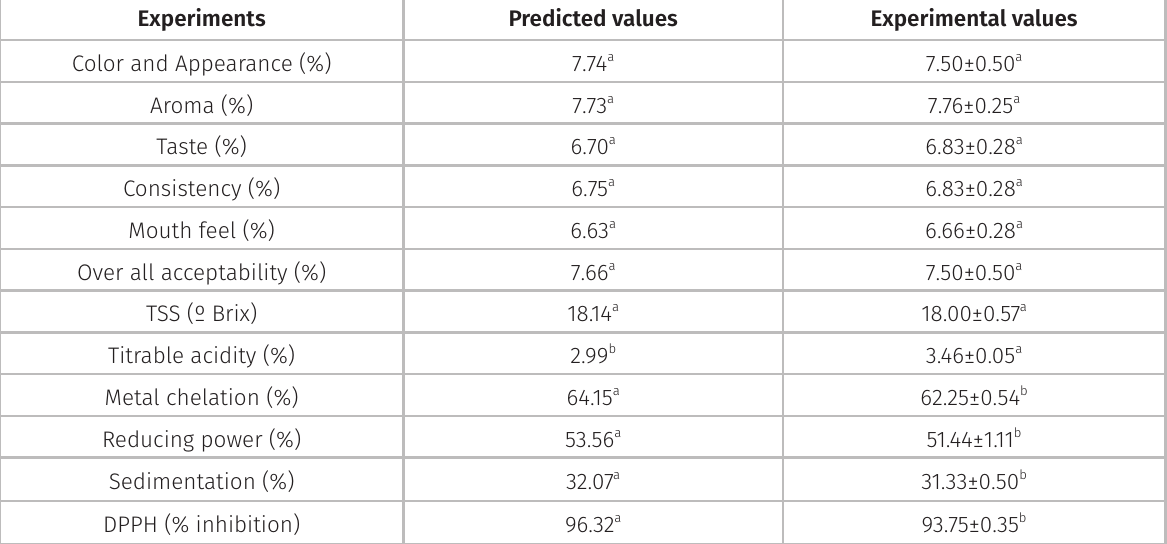
Table V. Optimization of micro green based